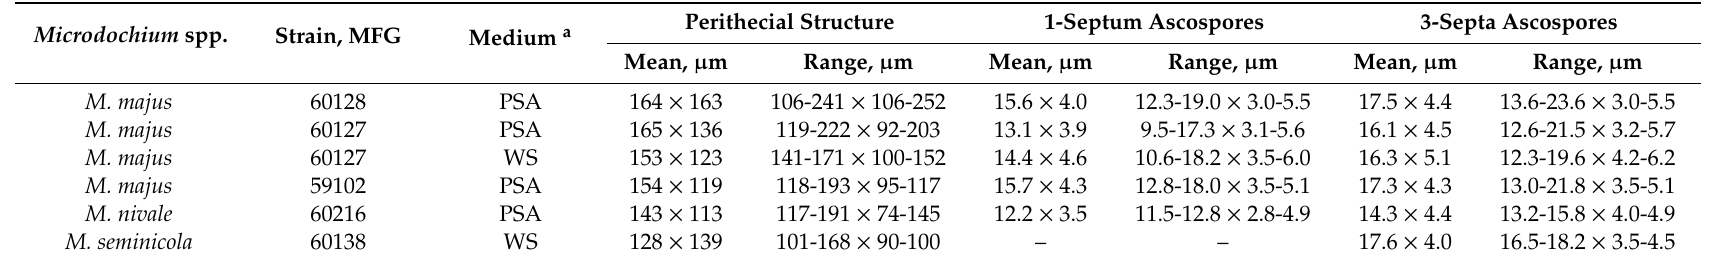
Table 3. Sizes of the structures in mature ascomata of Microdochium